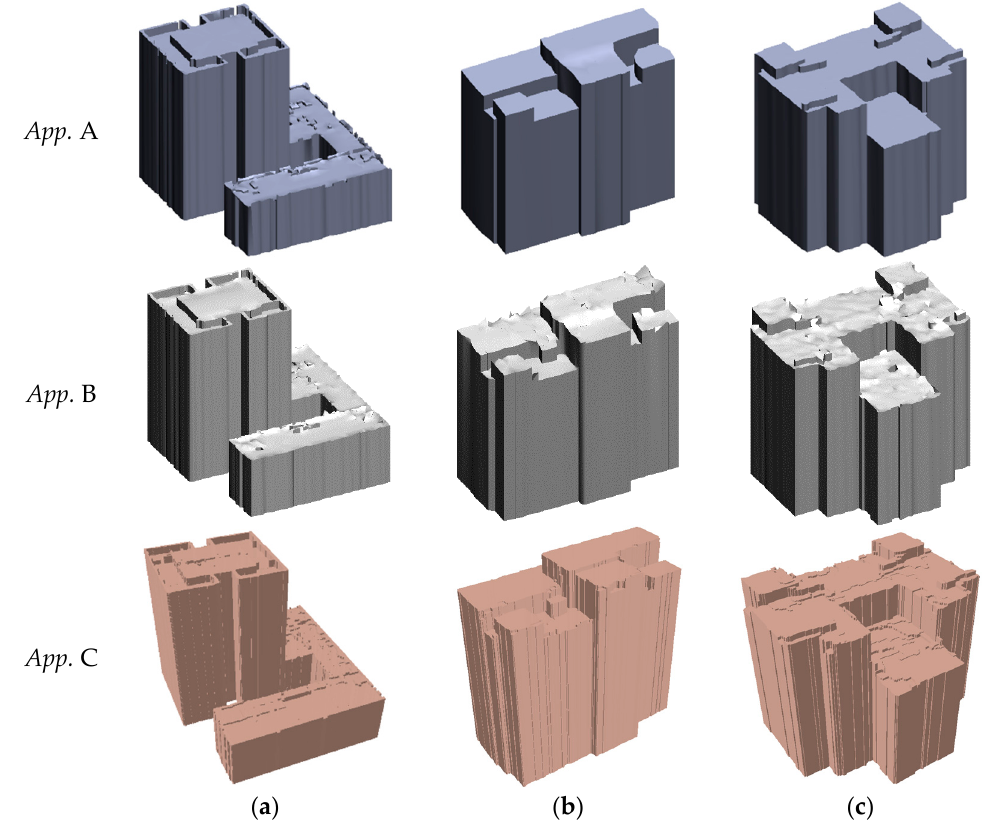
Figure 13. Comparison of Approaches (abbreviated as App. ) A, B, and C: ( a ), ( b ), and ( c ) The reconstructed roof models of Buildings 4, 5, and 6, respectively.